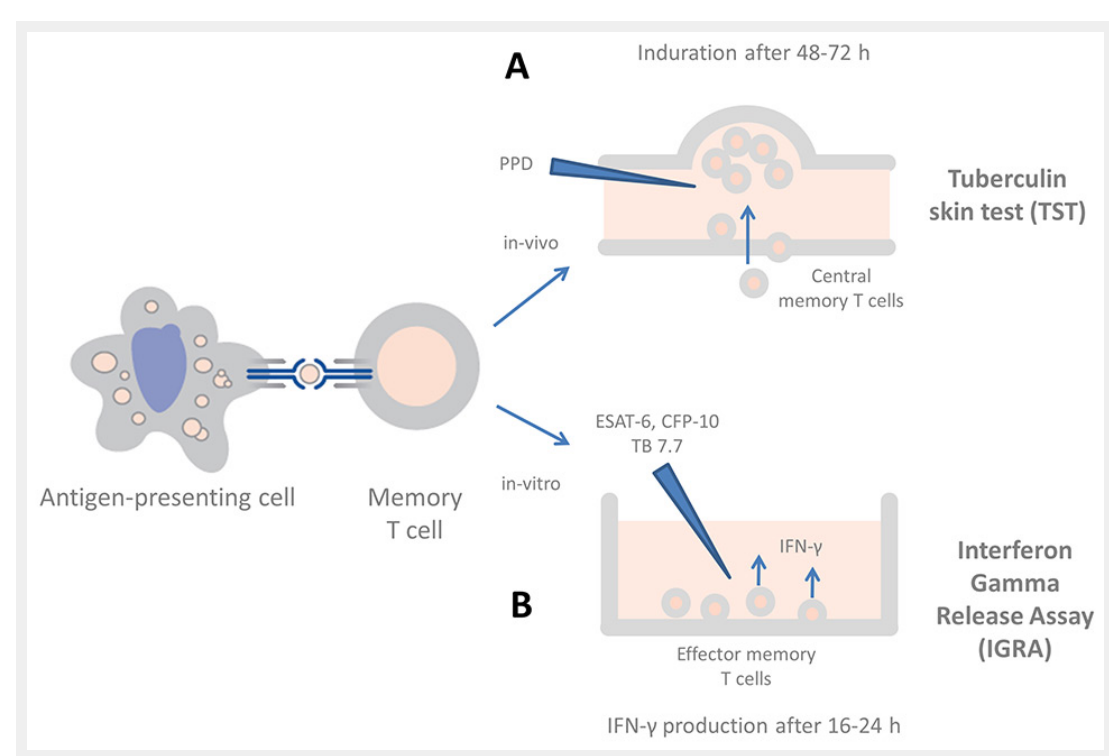
The current immunodiagnostic tests in clinical use for the diagnosis of tuberculosis (adapted from: Andersen P, Munk ME, Pollock JM, Doherty TM. Specific immune-based diagnosis of tuberculosis. Lancet. 2000;356(9235):1099–104, with permission from Elsevier). Exposure to M. tuberculosis leads to uptake by antigen-presenting cells and primes antigen-specific T cells in the local lymph node. (A) In the TST, after re- stimulation with PPD, mycobacterial-specific central memory T cells infiltrate the skin at the injection site and cause a palpable induration. (B) In IGRAs, blood is stimulated in vitro with ESAT-6, CFP-10 and (in the QFT-GIT only) TB 7.7, resulting in IFN-γ production by circulating effector memory T cells, which is measured by ELISA or ELISPOT.